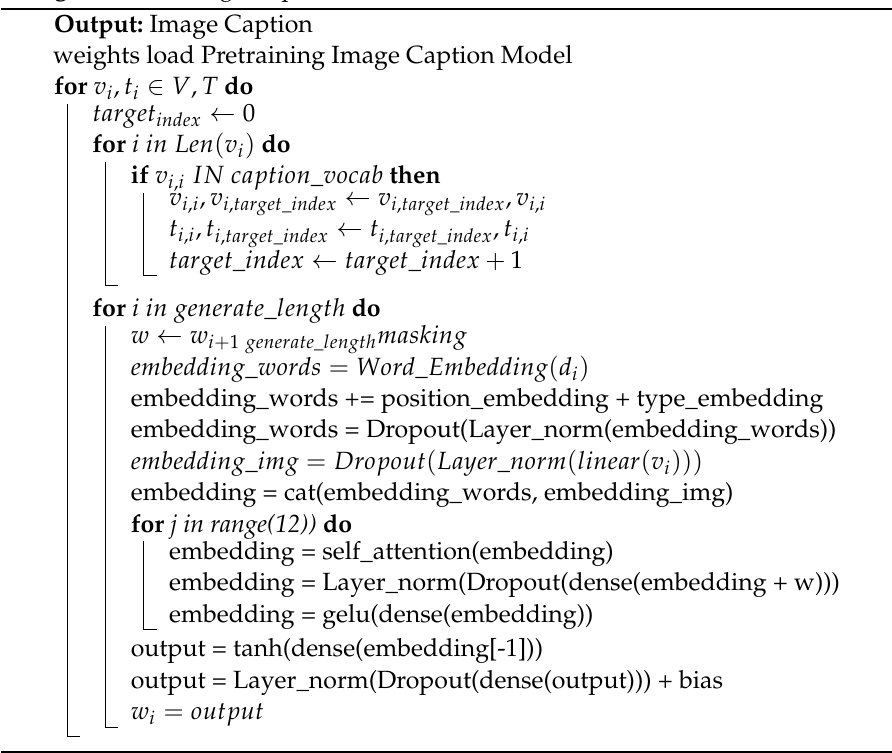
Algorithm 2: Image Caption